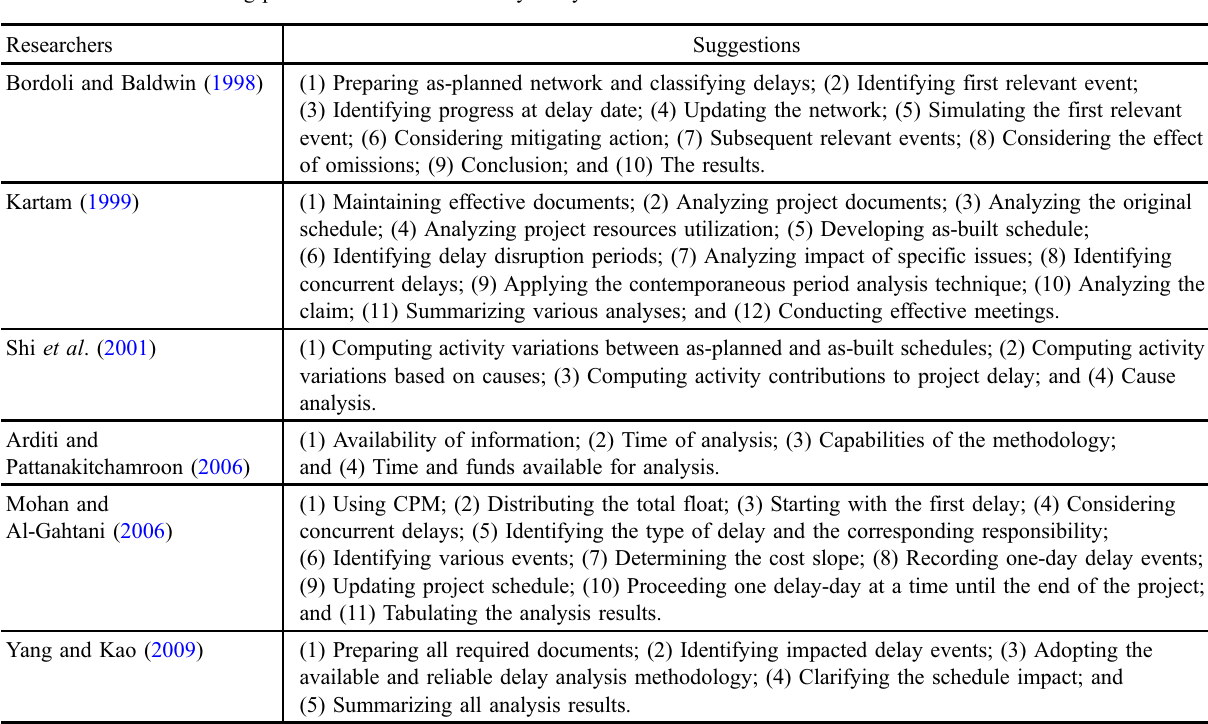
Table 1. A list for selecting process-based schedule delay analysis methods